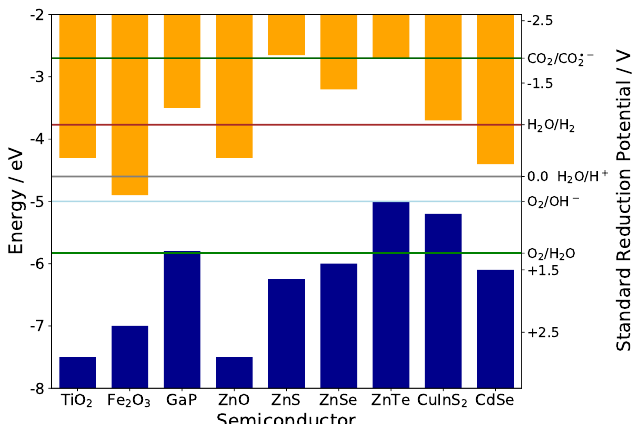
Figure 1. Band edge positions extracted from literature data [2–5] compared to Standard Reduction Potentials of some important redox